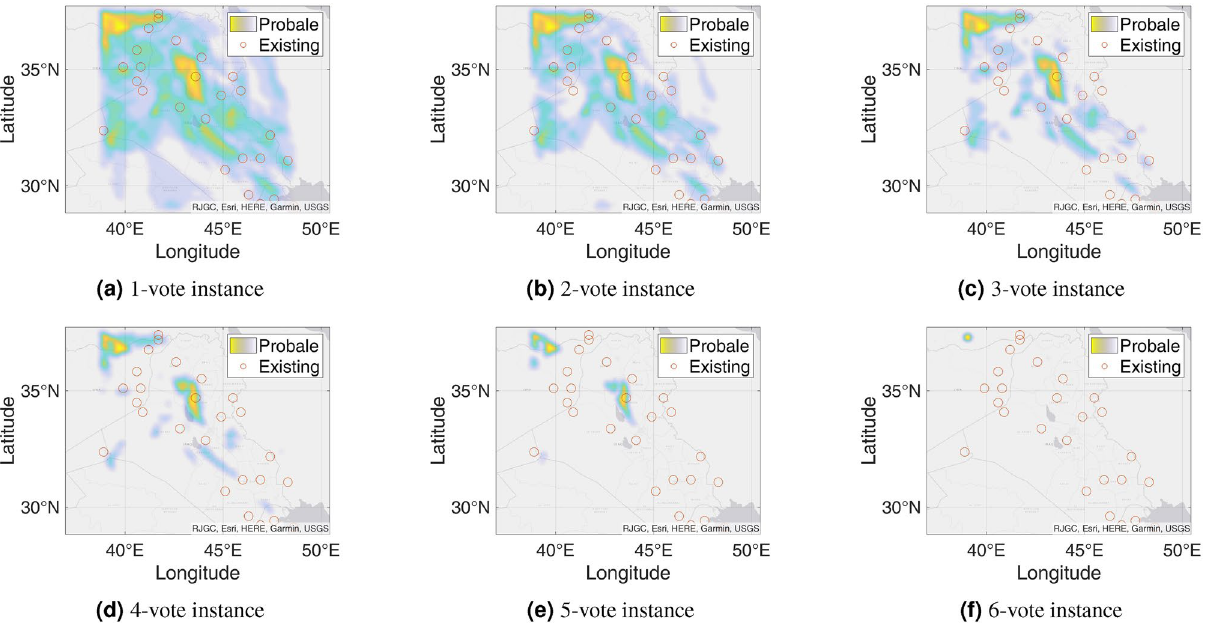
Figure 11. Probable petroleum deposits based on the frequency of 1 to 6 votes over our six best-performing models found from the graph-based analysis (the figures are created using MATLAB 2021a 51